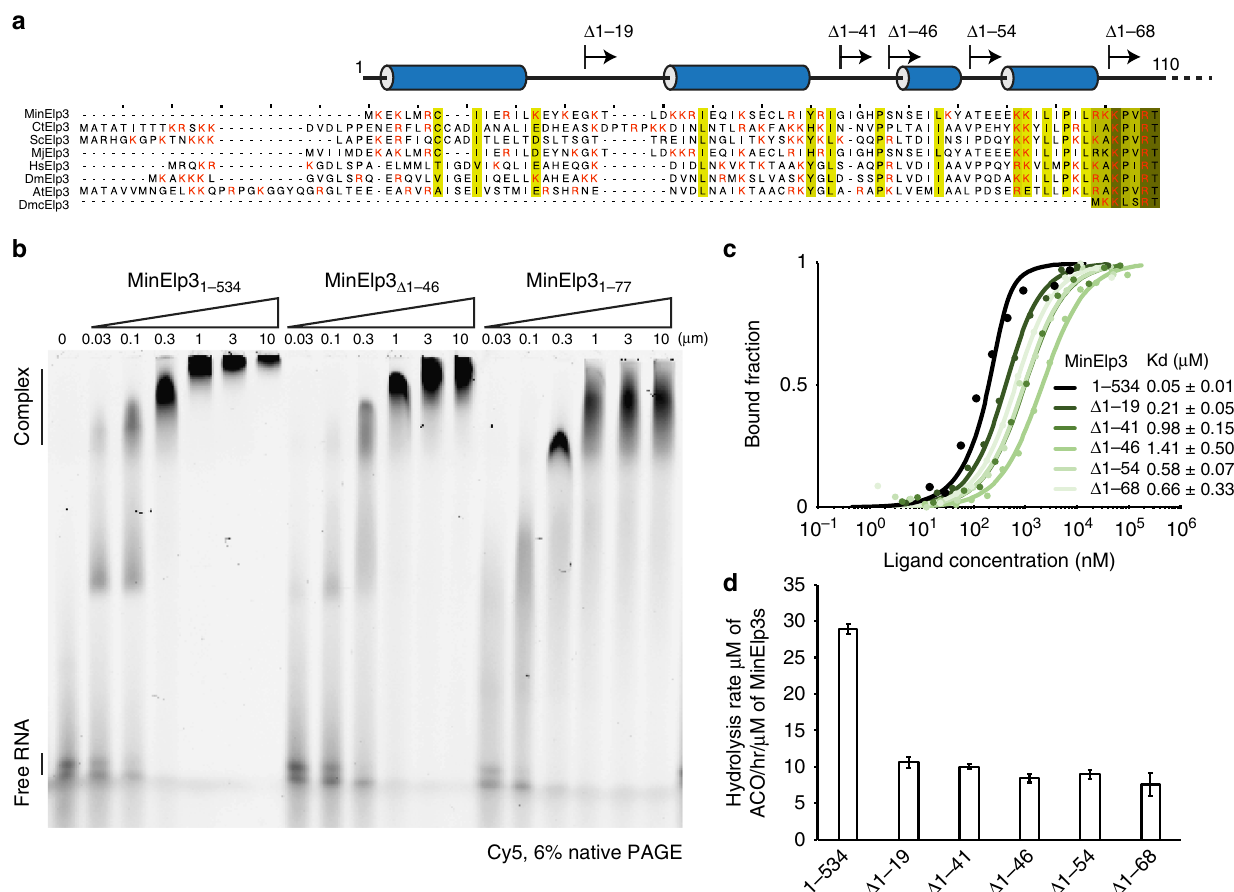
Fig. 3 N-terminus features of MinElp3 in tRNA binding and acetyl-CoA hydrolysis. a Sequence alignment of N-termini in selected Elp3 proteins. D. mccartyi (DmcElp3) (YP307690), M. infernus (MinElp3) (YP003616086), M. jannaschii (MjElp3) (AAB99138), S. cerevisiae (ScElp3) (NP015239), D. melanogaster (DmElp3) (NP608834), A. thaliana (AtElp3) (NP568725), H. sapiens (HsElp3) (NP060561), C. thermophilum (CtElp3) (XP_006697164.1). Relatively conserved residues are labeled in gradient green depending on the conservation scores. Basic residues are labeled in red. The predicted secondary structure elements of MinElp3 are indicated on top of the aligned sequences. The individual start sites of the truncated N-terminal constructs are indicated. b EMSA analyses of MinElp3s binding to yeast tRNA Ser UGA (Cy5-labeled). The samples were resolved in a 6% native PAGE and visualized using a Typhoon scanner. Protein concentrations are given and positions of free tRNA and protein-tRNA complex are labeled. c MST analyses of MinElp3s binding to (Dmc) tRNA Glu UUC and the K d s are indicated, n = 3. d Acetyl-CoA hydrolysis reaction of different MinElp3 N-terminus truncations in the presence of endogenous yeast bulk tRNA ( Δ elp3; UMY2916), n = 3. Data represent mean ± SEM. Source data are provided as a Source Data fi